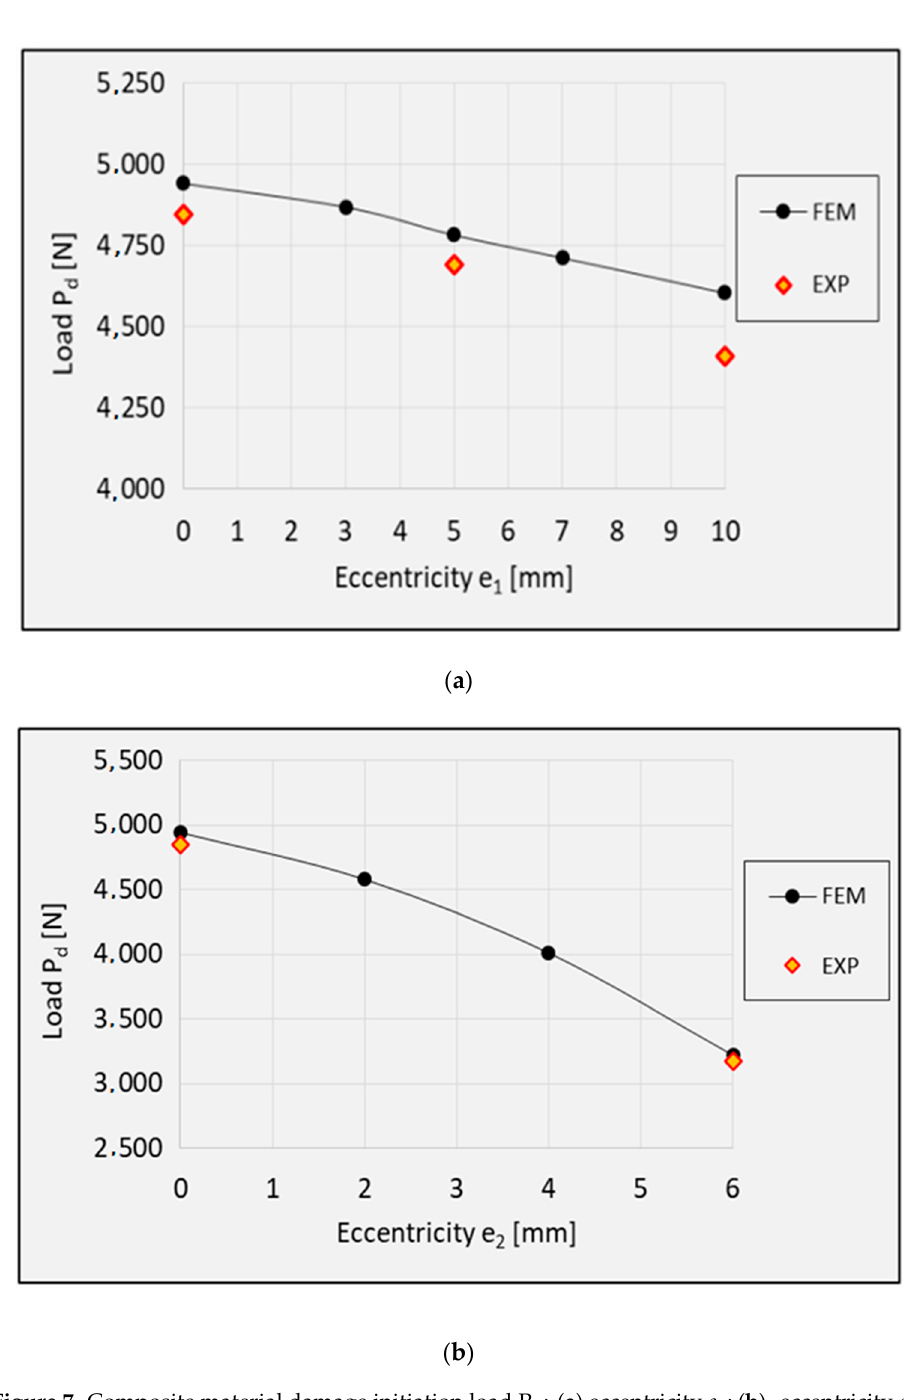
Figure 7. Composite material damage initiation load P d : ( a ) eccentricity e 1 ; ( b ). eccentricity e 2 . Table 2. Composite material damage initiation load P d versus